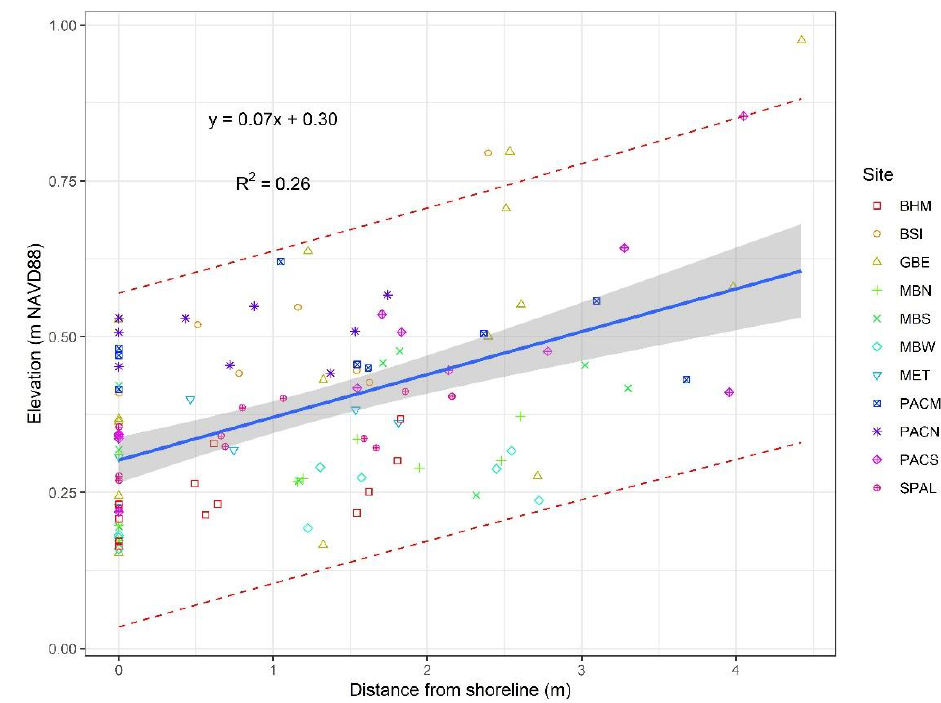
Figure 3. Scatter plot of marsh platform elevations against distance from the shoreline (shoreline is located at 0) with the least-squares linear regression line (blue solid line), indicating marsh platform slope is approximately 0.07. Red dashed lines depict the 95% prediction interval and grey-shaded region show the 95% confidence interval. NAVD88 = North American Vertical Datum of 1988. Site names refer to: BHM = Bayou Heron Mouth; MBN, MBW, MBS = Middle Bay North, West, and South, respectively; GBE = Grand Batture East; BSI = Bird Island; SPAL = North Jose Bay; MET = Met Station Island; PACN, PACM, PACS = Point aux Chenes North, Middle, and South, respectively.